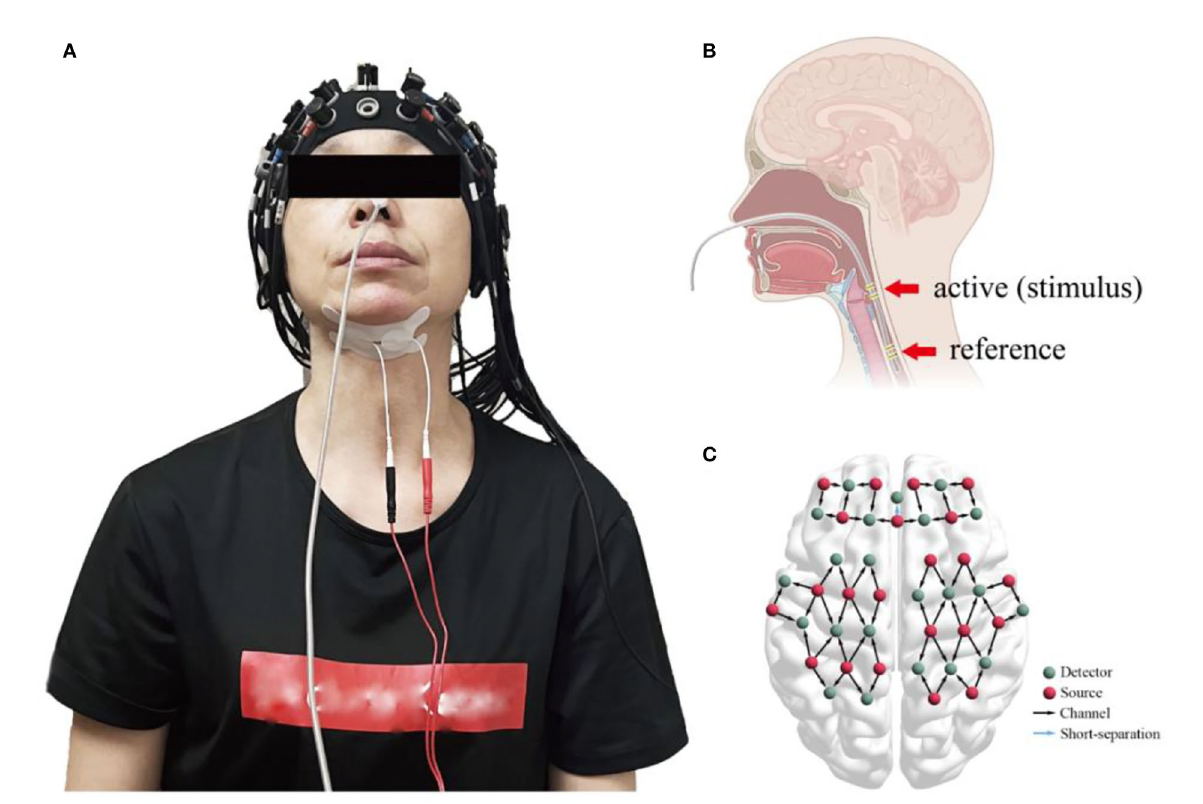
FIGURE2 (A) fNIRS monitors cortical activities induced by mPES or sham procedures while bipolar skin electrodes of the surface EMG measure the duration of swallowing and the number of swallows; (B) the location of mPES; (C) cap placement and channel locations. fNIRS, functional near-infrared spectroscopy; mPES, modified pharyngeal electrical stimulation; EMG,